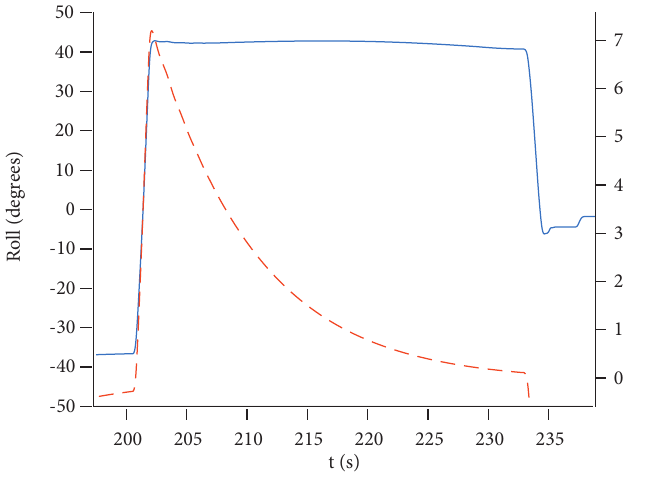
Figure 10. Zoom of the comparison between the airplane and the SIVOR cockpit roll behaviors.